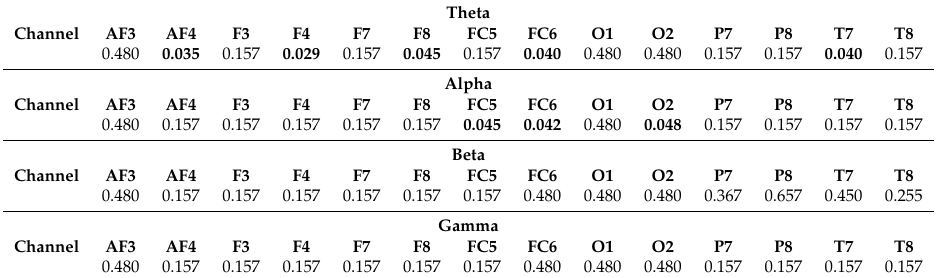
Table 2. p -value from Mann-Whitney test in a single participant ( P 2) for segments of 15